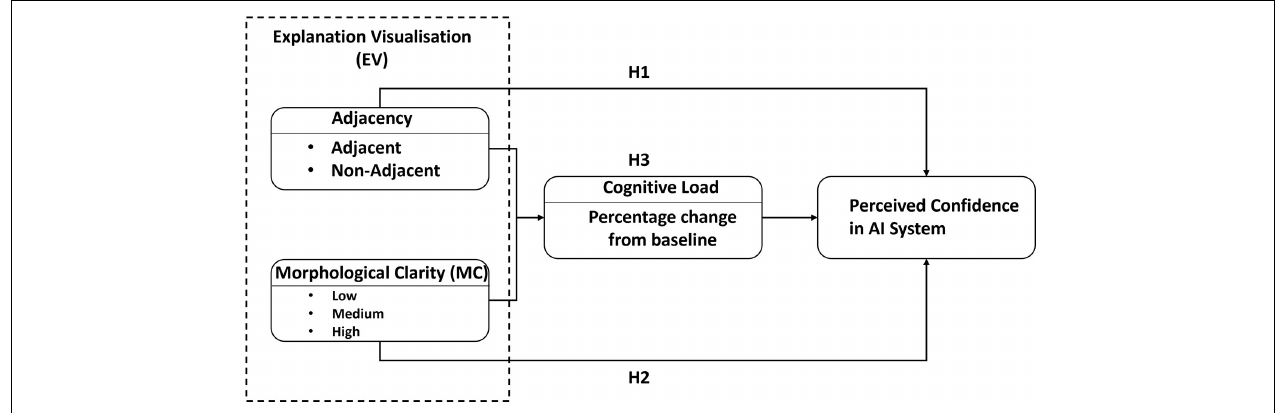
FIGURE 1 | Research